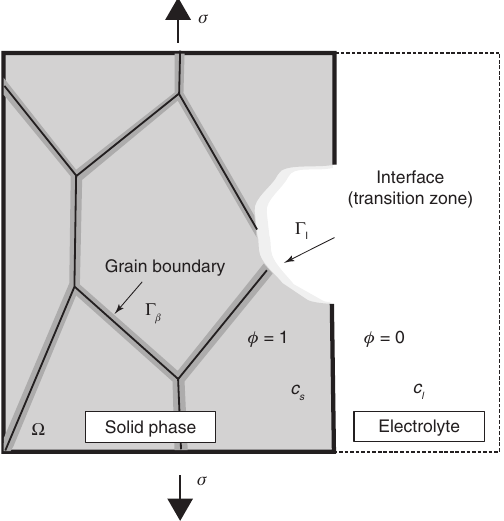
Figure 1: 2D representation of a typical corroding system due to the anodic dissolution of a polycrystalline